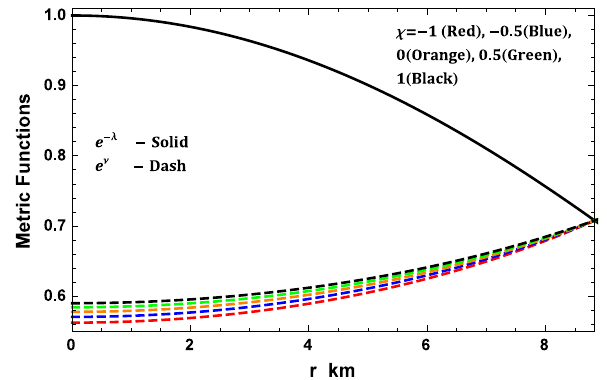
Fig. 1 Variation of metric potentials w.r.t radial coordinate r for M = 1 . 29 M (cid:9) , R = 8 . 831 km and b = 0 . 0031km −